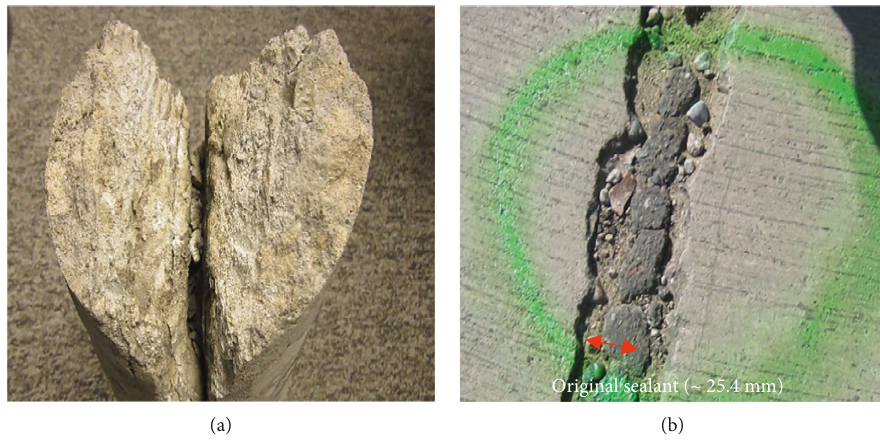
Figure 2: Typical F-T deterioration: (a) F-T damage and (b) joint